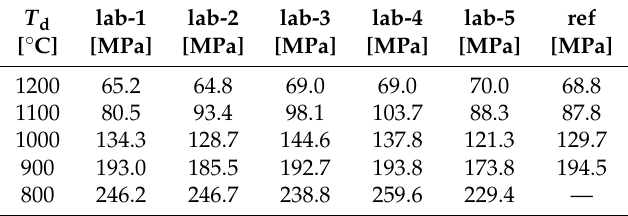
Table 3. Maximum equivalent stresses σ e for deformations from 800 ◦ C to 1200 ◦ C.